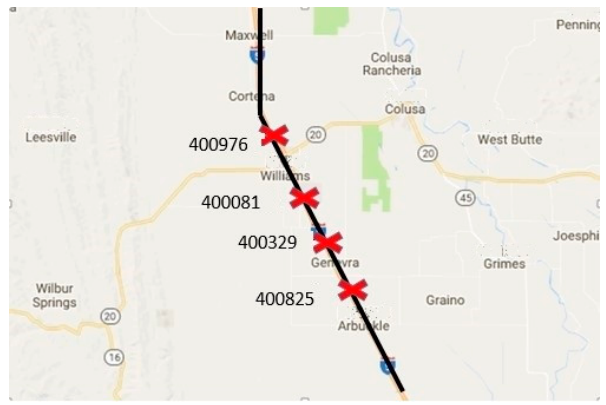
Figure 3. Locations of the study detector stations.